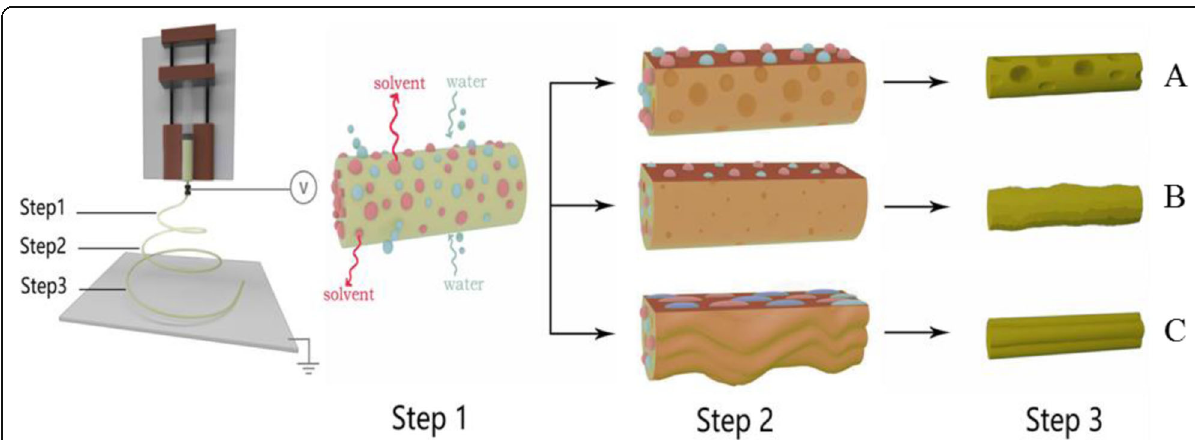
Fig. 3 Process diagrams of the solution jet during electrospinning at high relative humidity. Step 1: the evaporation of the solvent and water condensation, step 2: the penetration of water droplets and generation of pores, and step 3: elongating and solidification of fibers. a Macro-porous fibers, b rough fibers, and c grooved